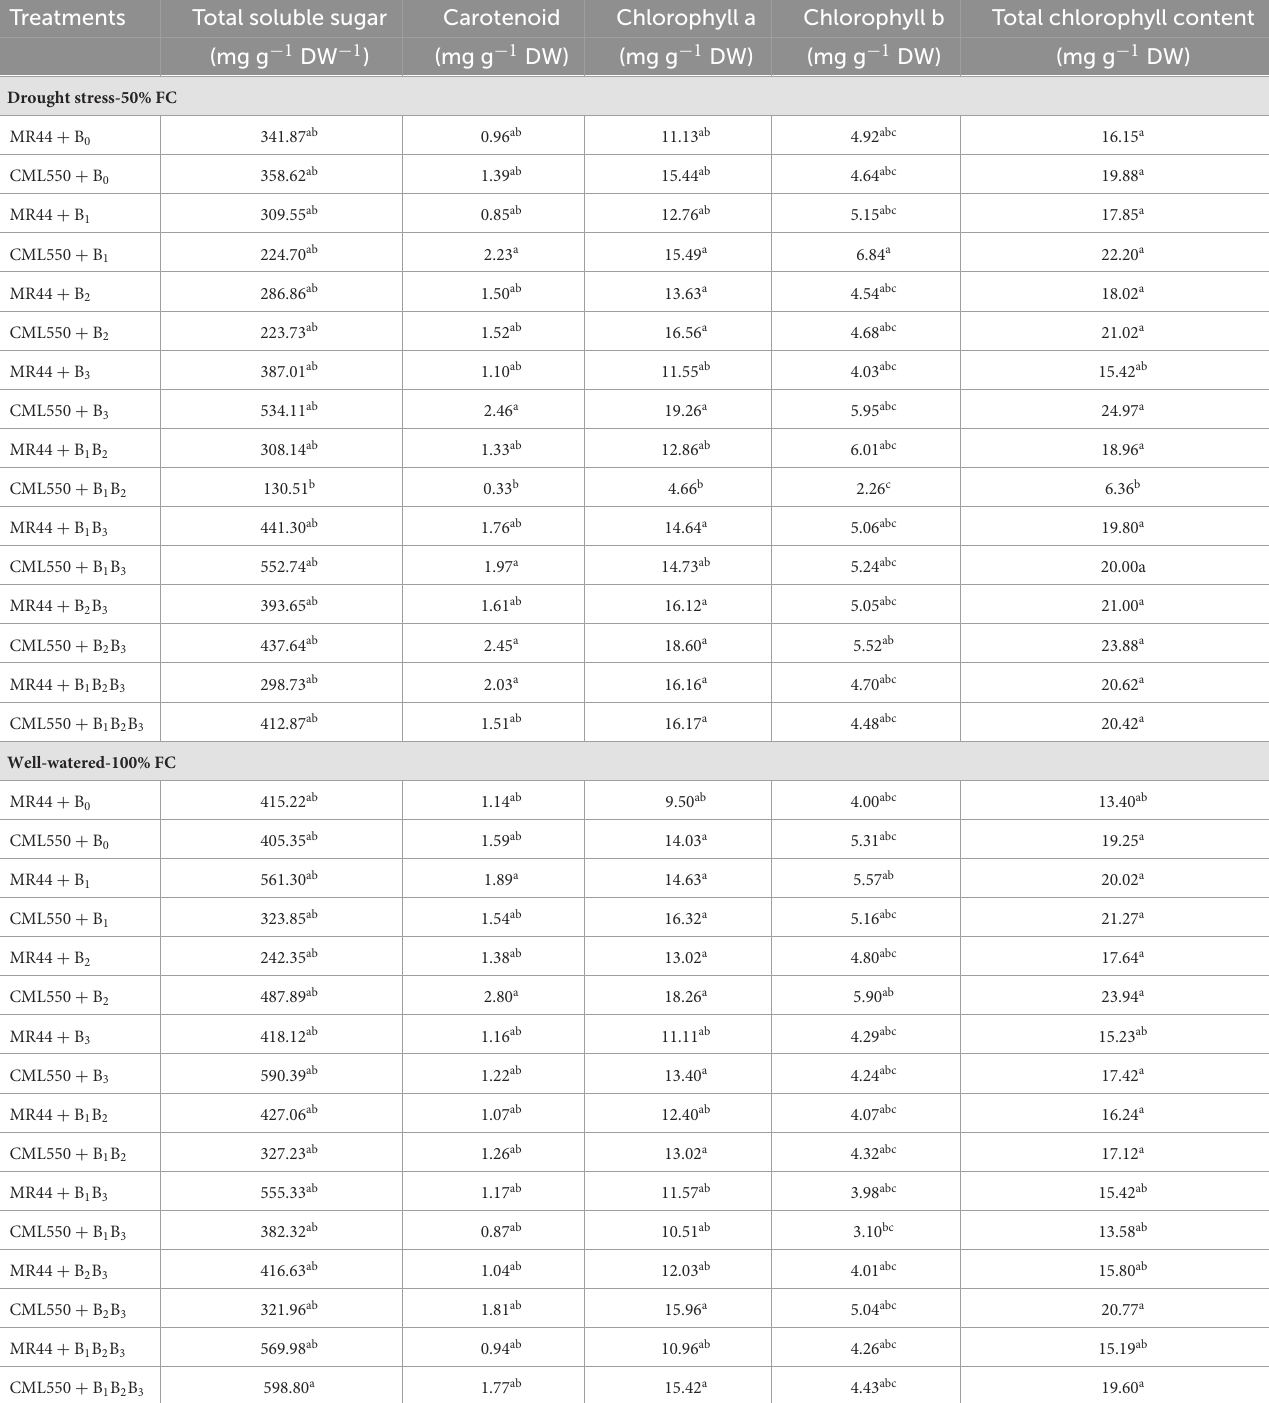
TABLE 5 Effect of treatments on total soluble sugar and chlorophyll content production under drought stress (50% FC) and well-watered (100% FC) conditions.